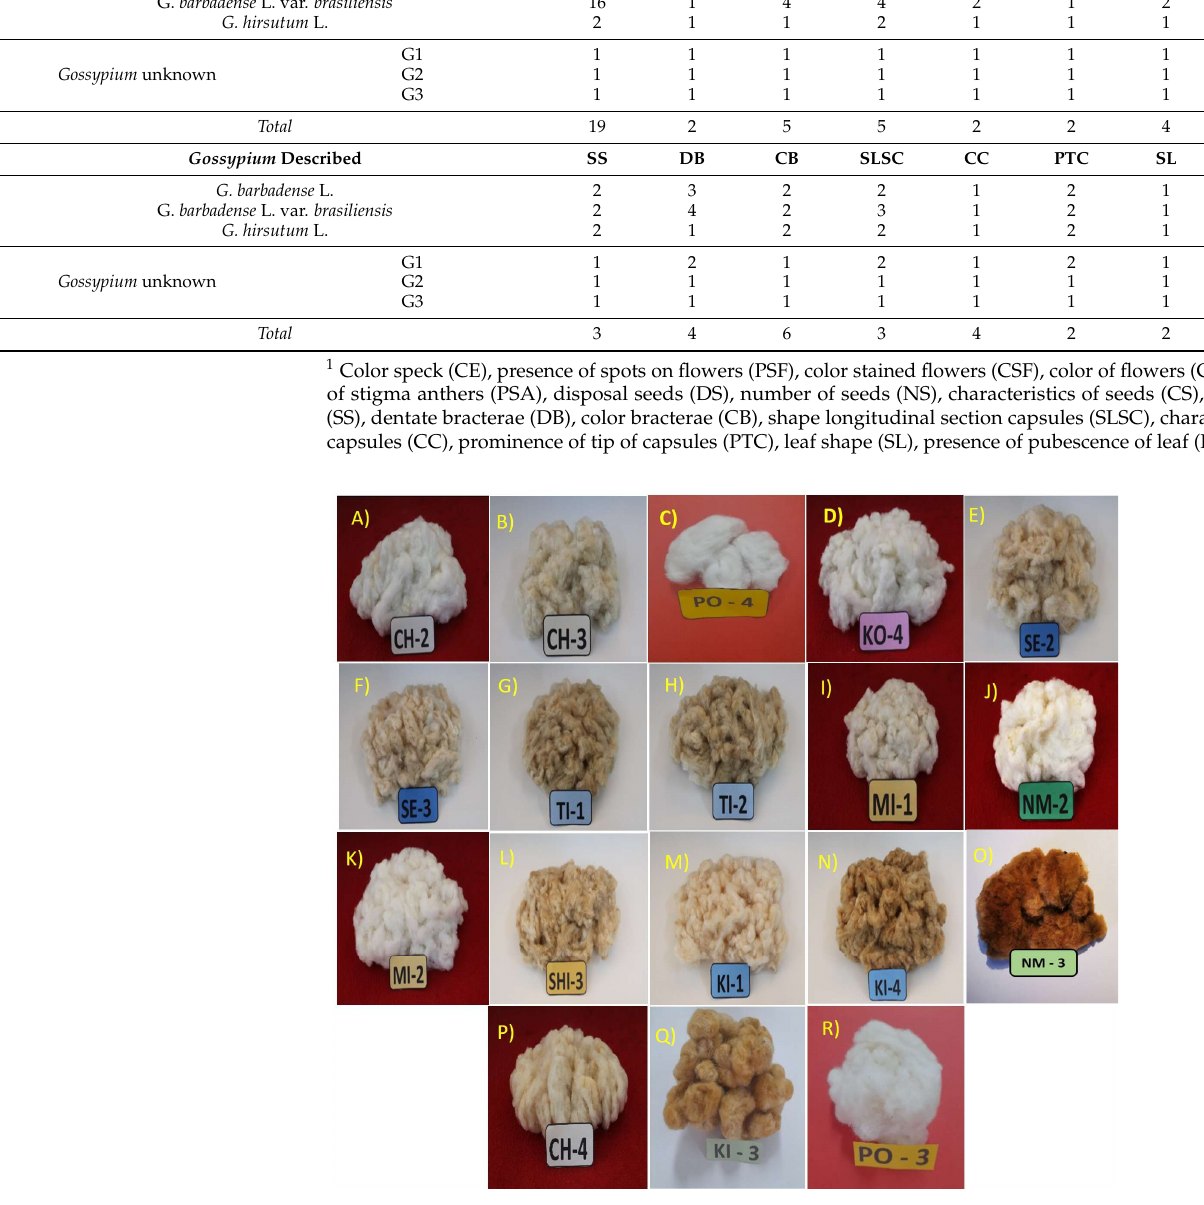
Figure 4. Representation of the colors of the cotton balls obtained in five groups of cotton species [ G. barbadense L. ( D , F , I , M , P , Q ), G. barbadense L. var. brasiliensis ( A , B , E , G , H , J , K , L , N , O ), G hirsutum L. ( C ) and the unknown group G1 ( R )] collected in the province of La Convención, in the districts of Echatari and Megantoni, Cusco-Peru. In ( A ) Floral white; CH-2: Chacopishiato, ( B ) Smoke white; CH-3: Chacopishiato, ( C ) White; PO-3: Poyentimari, ( D ) Anti-flash white; KO-4: Koribeni, ( E ) Pastel brown; SE-2: Sensa, ( F ) Old white; SE-3: Sensa, ( G ) Moccasin; TI-1: Timpia, ( H ) Pearl; TI-2: Timpia, ( I ) Alabaster; MI-1: Miaria, ( J ) Cult; NM-2: New World, ( K ) Chinese white; MI-2: Miaria, ( L ) Champagne; SHI-3; Shivankoreni, ( M ) Bleached almond; KI-1: Kirigueti, ( N ) Camel; KI 4: Kirigueti, ( O ) Brown; NM-3: New World, ( P ) Pink stick; CH-4: Chacopishiato, ( Q ) Brown; KI 3: Kirigueti, and ( R ) Creamy white; PO-3: